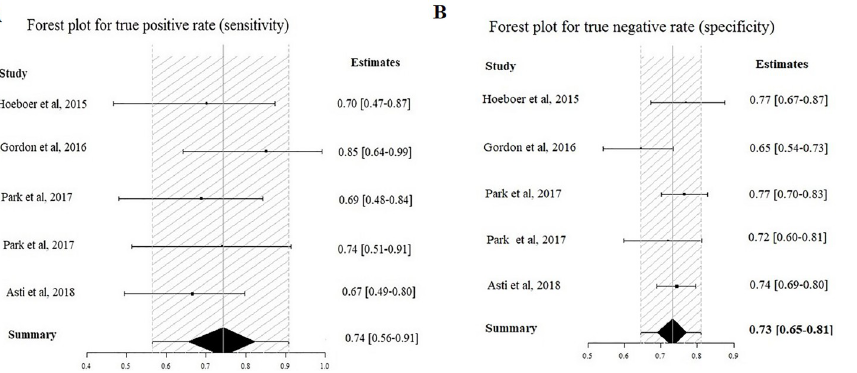
Fig 4. Forrest plot for POD3: Estimated pooled sensibility (A) and specificity